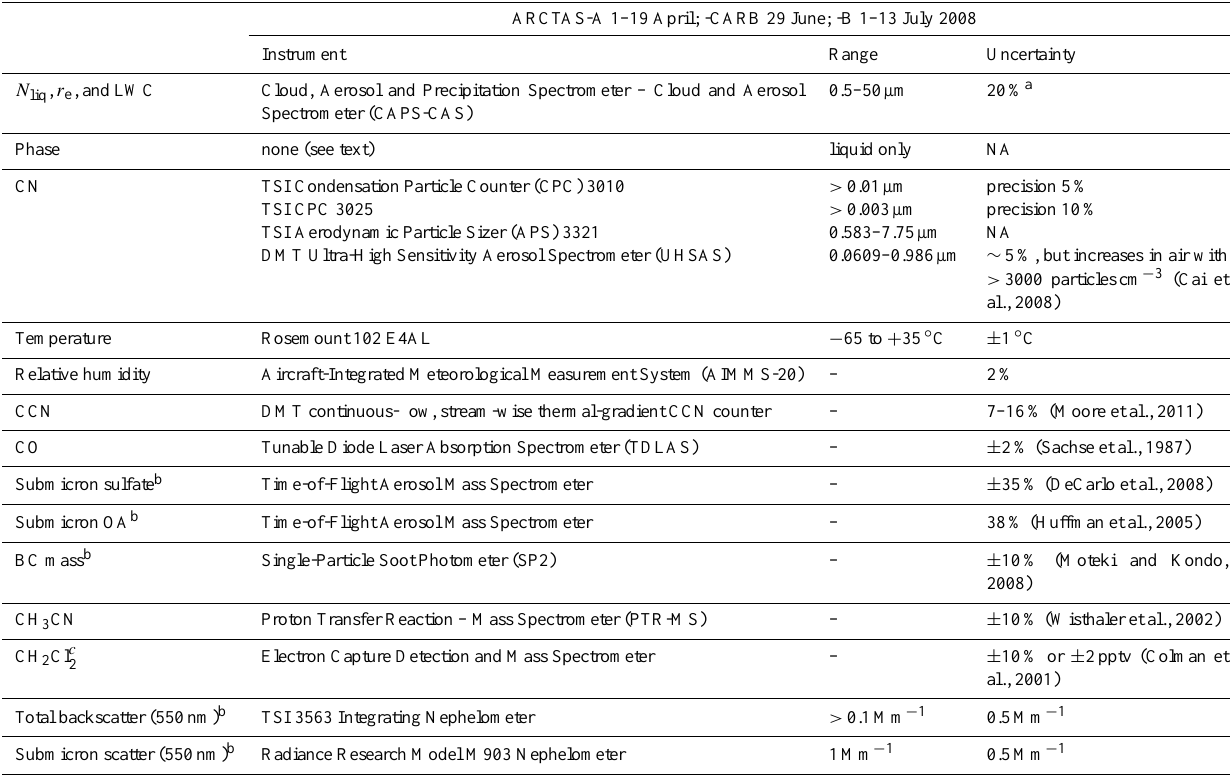
Table 1. Instrumentation used in this study from the ARCTAS data set. Data were collected at 1s resolution, unless noted otherwise.